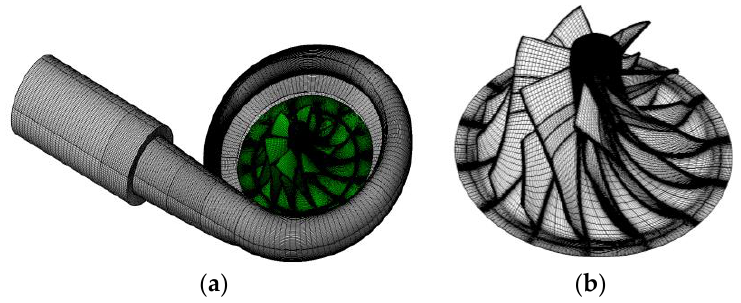
Figure 3. Grid of the centrifugal compressor: ( a ) Compressor mesh; ( b ) Impeller mesh.